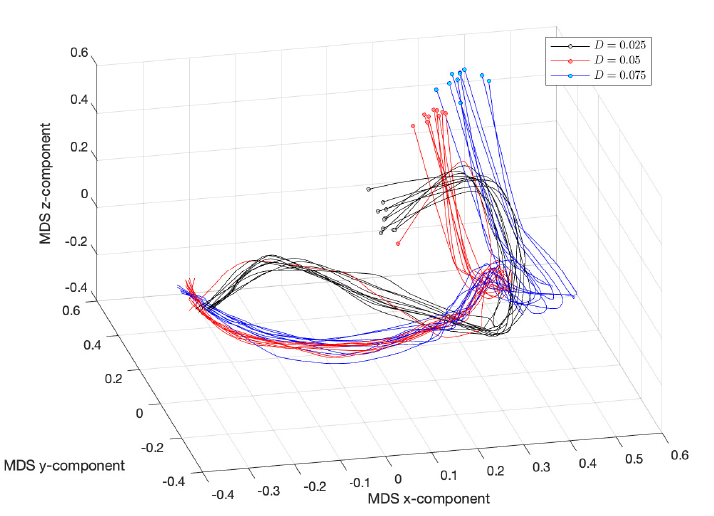
Figure 19. The 3-dimensional multidimensional scaling (MDS) locus, using the Canberra distance (3), t ∈ { 1, . . . ,30 } , for D = { 0.025,0.05,0.075 } ( N = 500, δ = 0.1, p 1 = 0.1, p 2 = 0.9, p 3 = 0.7, p 4 = 0.05, p 5 = 0.02, α = 2 and N h → ∞ ).